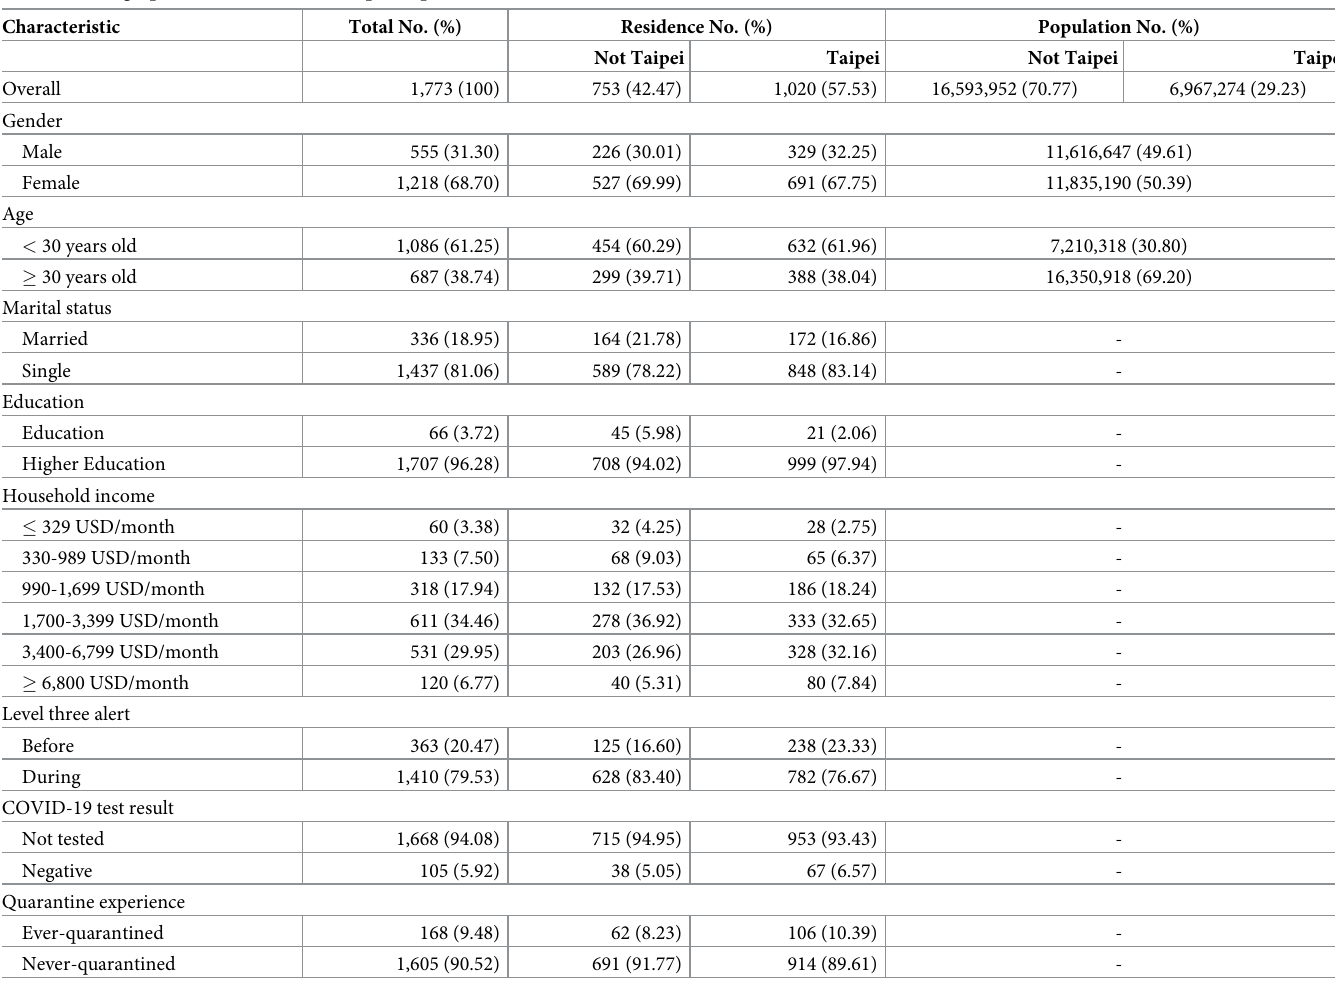
Table 2. Demographic characteristics of the